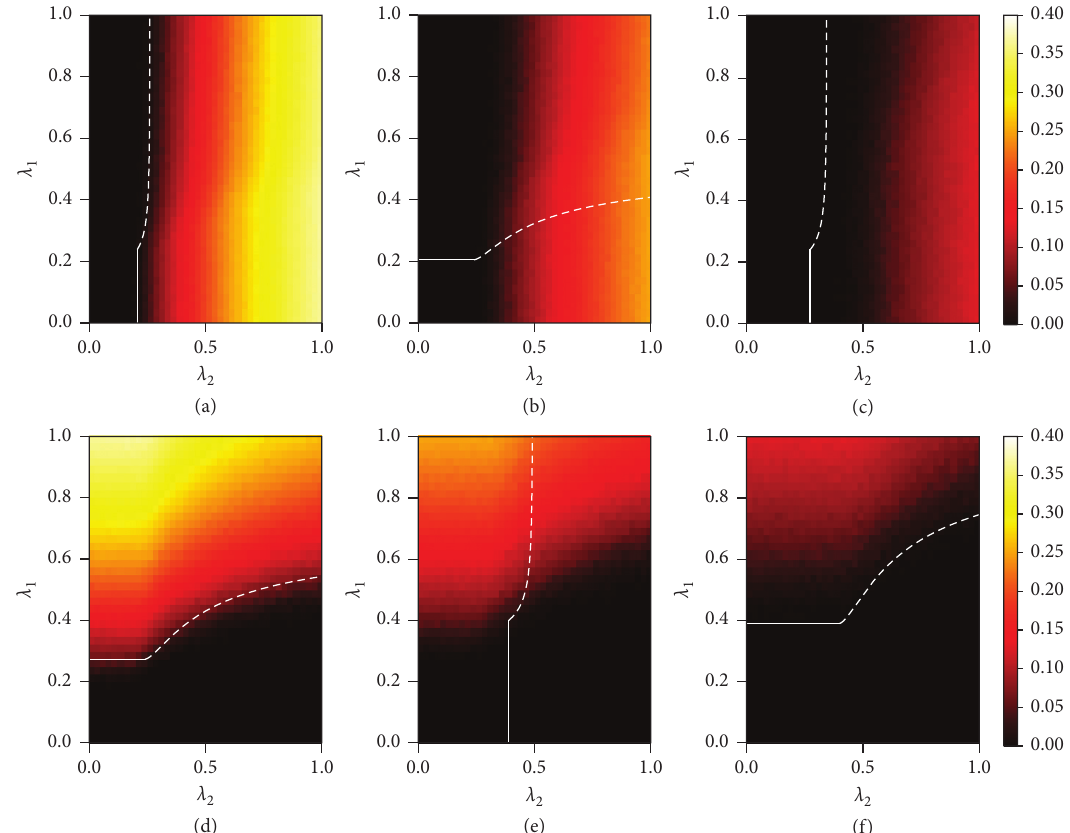
Figure 2: Product information diffusion mutual suppressed